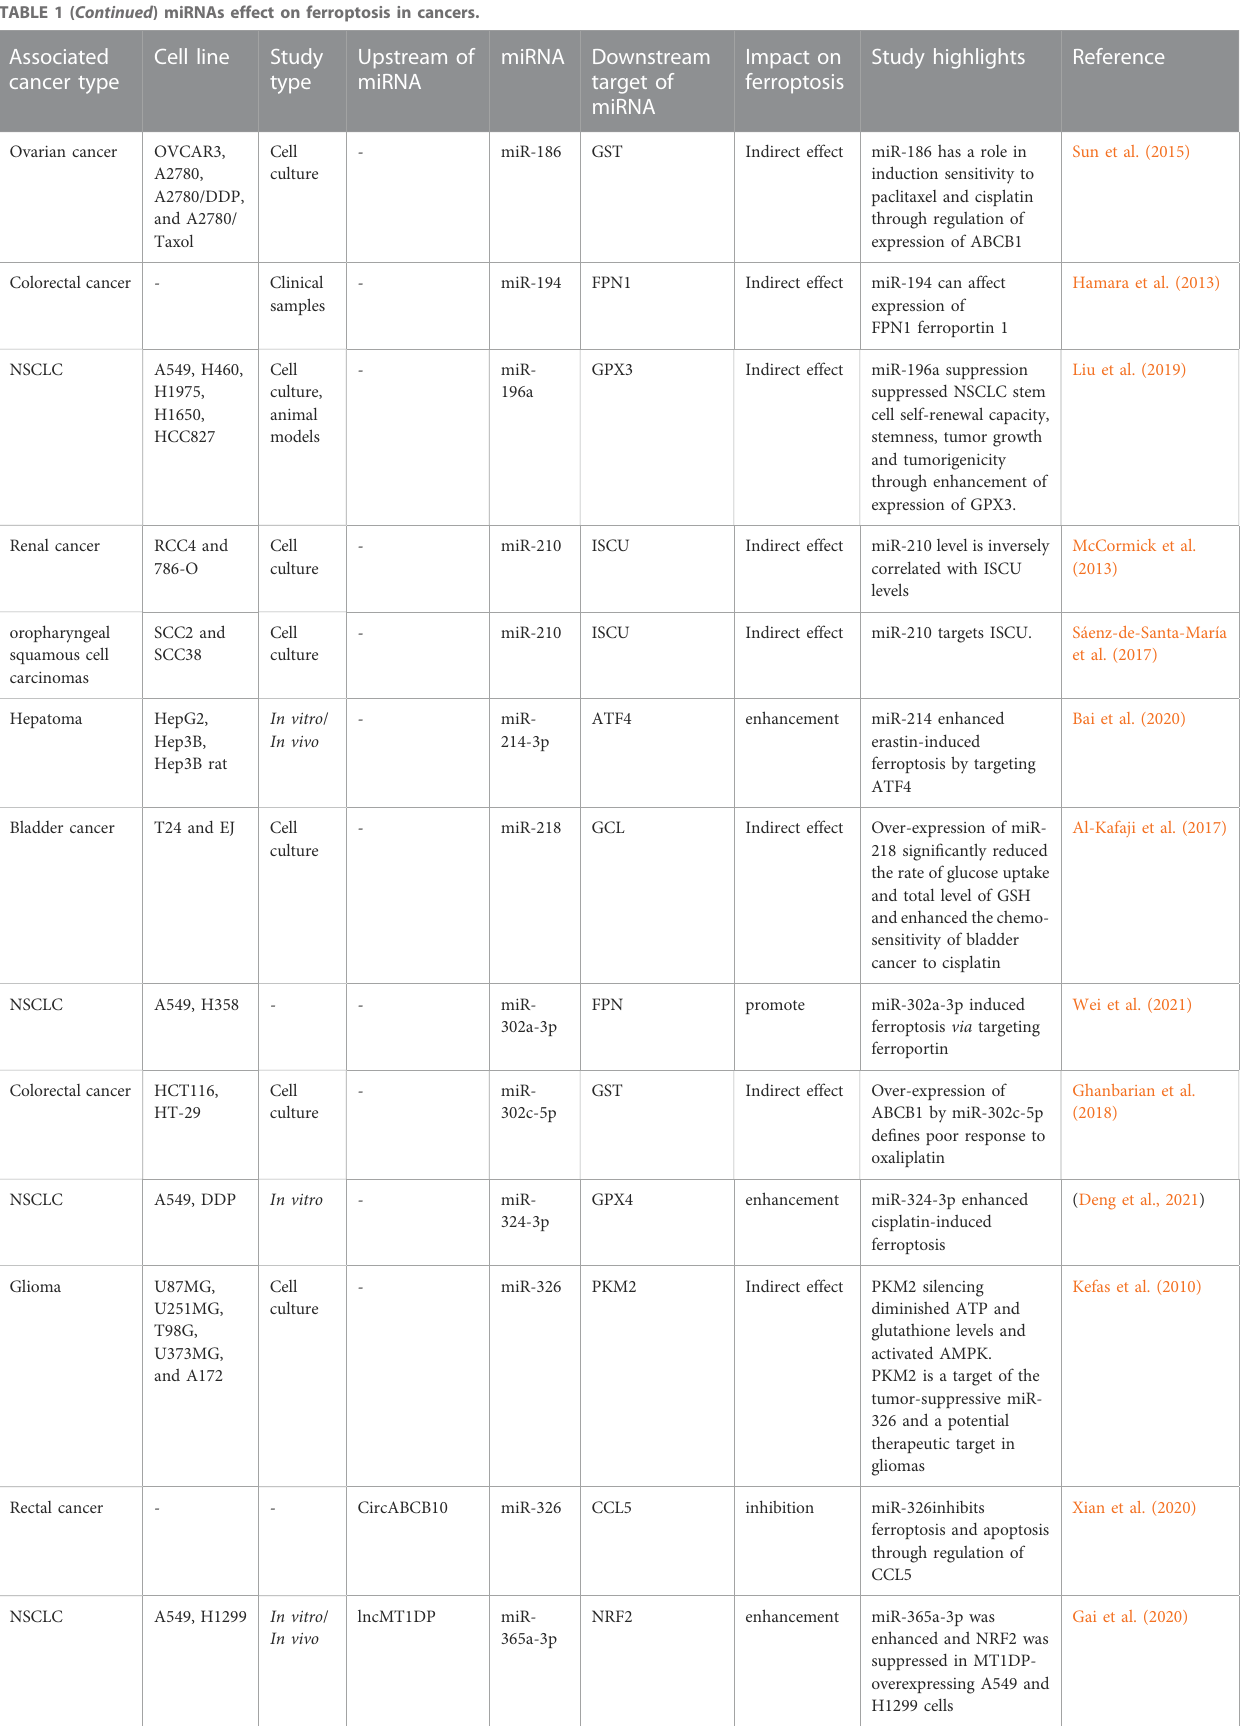
TABLE 1 ( Continued ) miRNAs effect on ferroptosis in